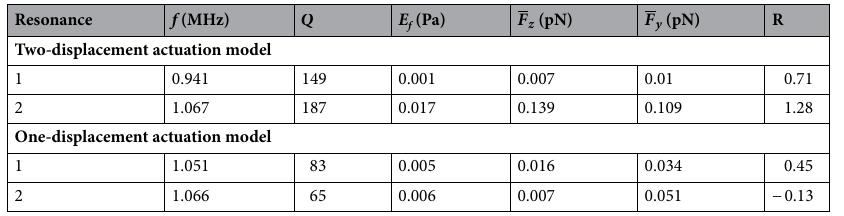
Table 3. The values of resonance frequency (f), Q factor, acoustic energy density of the fluid ( E f ) , average acoustic radiation force in the z direction ( F z ) , average acoustic radiation force in the y direction ( F y ) and R shown in Fig. 3 for the PDMS microchannel.